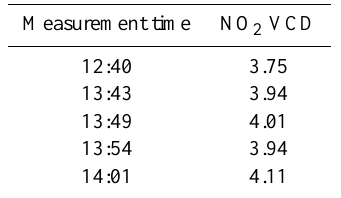
Table 6. Average VCD measurements in moleccm − 2 × 10 16 for region 2 in Table 5 for five